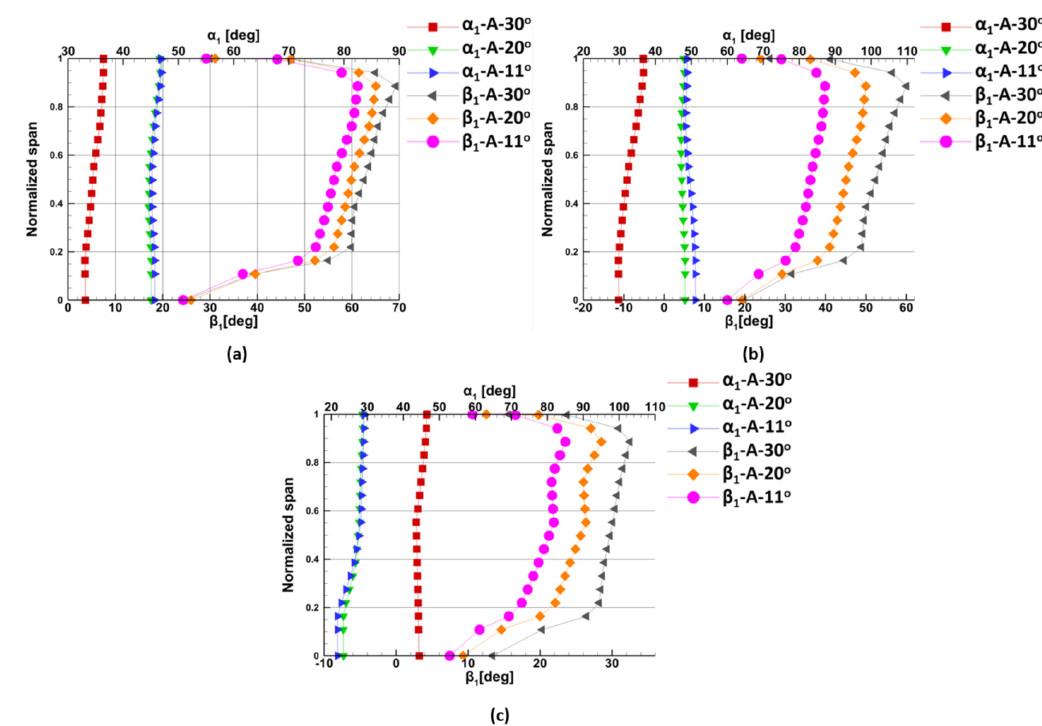
Figure 31. The plots of the absolute ( α 1 ) and relative ( β 1 ) angles measured behind the 1st stage nozzle vane against the blade height at 50,000 rpm for: ( a ) point A, ( b ) point B, ( c ) point C.